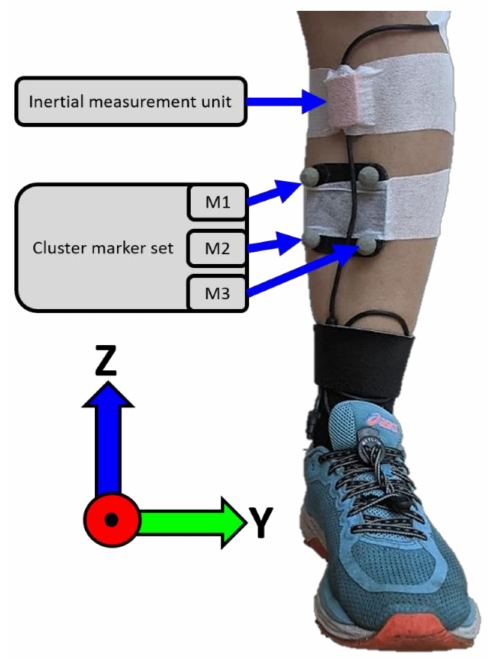
Figure 1. Overview of IMU and cluster marker set placement. “M1”,”M2”, and “M3” refer to the individual markers of the cluster marker set. The shown coordinate system is the functional coordinate system Ψ f . The X-axis points forward (running direction), the Y-axis mediolateral, and the Z-axis